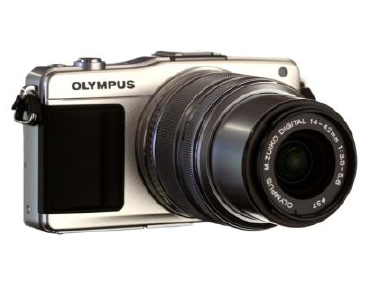
Figure 2. Olympus Pen E-PM2